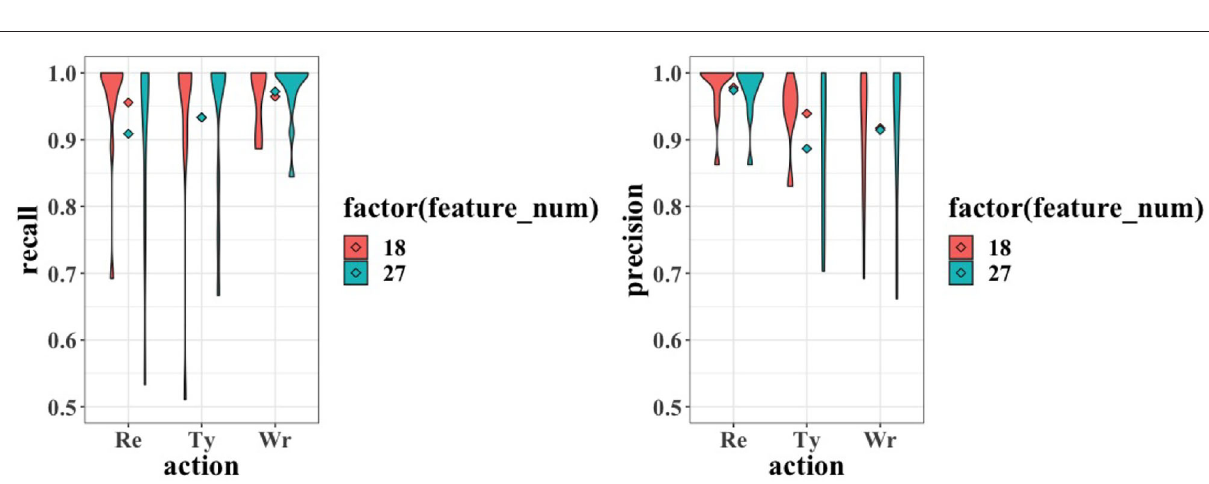
FIGURE 8 | Violin plot for the recall (left) and precision (right) values of the working status. Each violin shows the distribution of the corresponding metric over the LOO validation, whereas the dots in the middle of each pair of violins show their